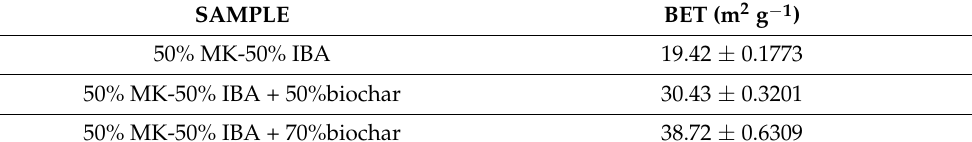
Table 6. BET of 50% MK-50% IBA with the addition of 50 or 70% of biochar at 28 curing days.